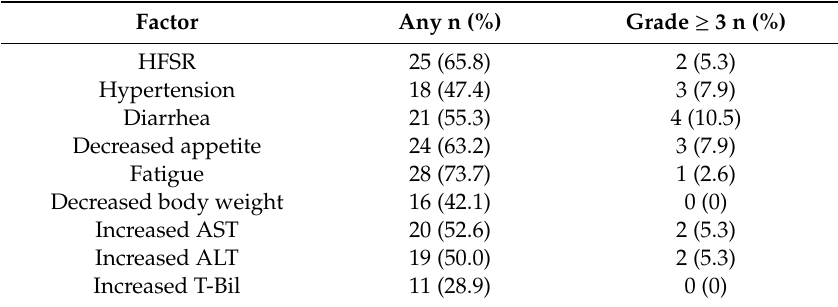
Table 4. Adverse events ( >